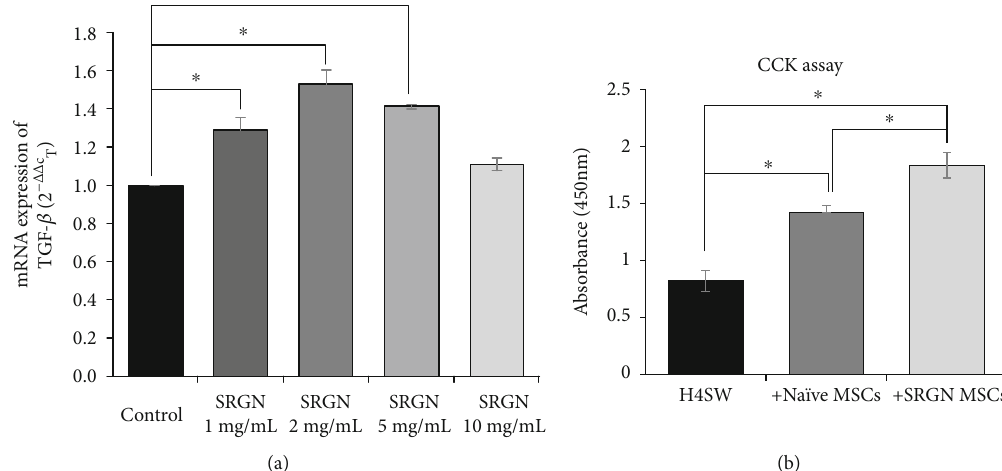
Figure 8: E ff ects of SRGN-primed MSCs. (a) The mRNA was extracted from SRGN-primed MSCs and analyzed by qPCR using a speci fi c primer for human TGF- β . ∗ p < 0 : 05 , n = 3 . (b) Viability of H4SW cells under serum-starved conditions analyzed by CCK-8 assays. Three samples per experimental group were tested in each assay. The data are presented as the mean ± S : E : M . ∗ p < 0 : 05